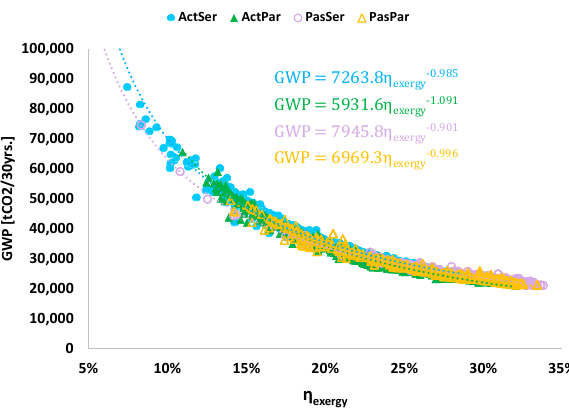
Figure 19. Relation between η exergy and GWP.